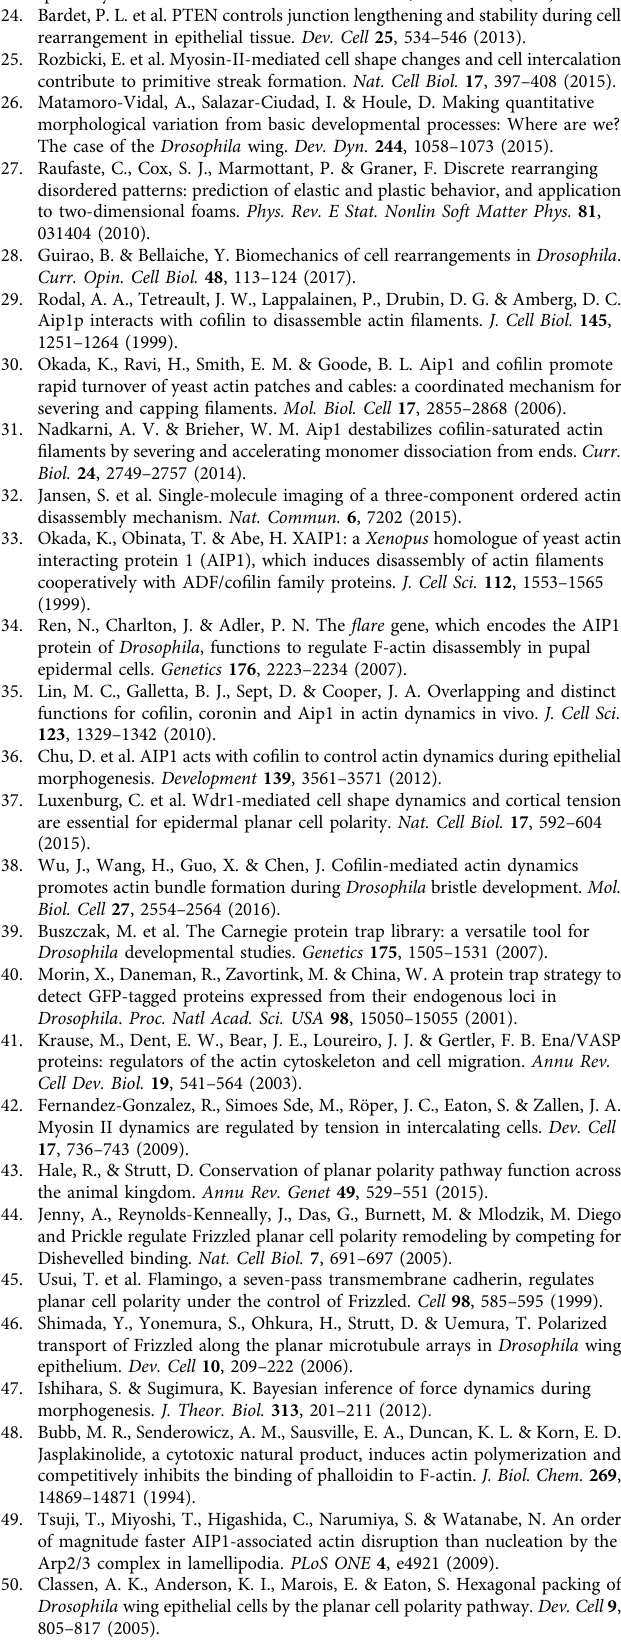
(Figs. 1l, 2d, 4d, f, g, 9i, Supplementary Figure 5c, d, Supplementary Figure 8d, e), the Wilcoxon rank sum test (Fig. 9f), Dunnett ’ s test (Fig. 2g, h, Supplementary Figure 4, Supplementary Figure 5a, b), the Steel test (Fig. 6j, Fig. 8e), the Steel – Dwass test (Figs. 7b, 8i, Supplementary Figure 10c, f), and a